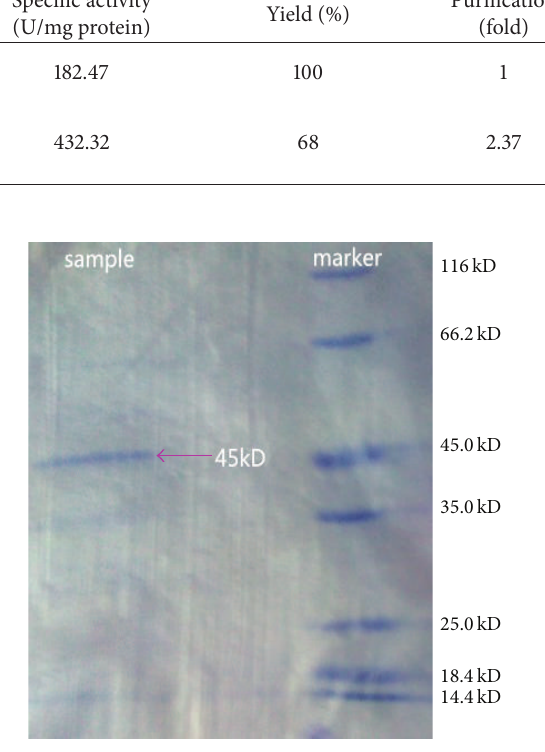
Figure 3: SDS-PAGE electrophoresis of the crude protease of strain